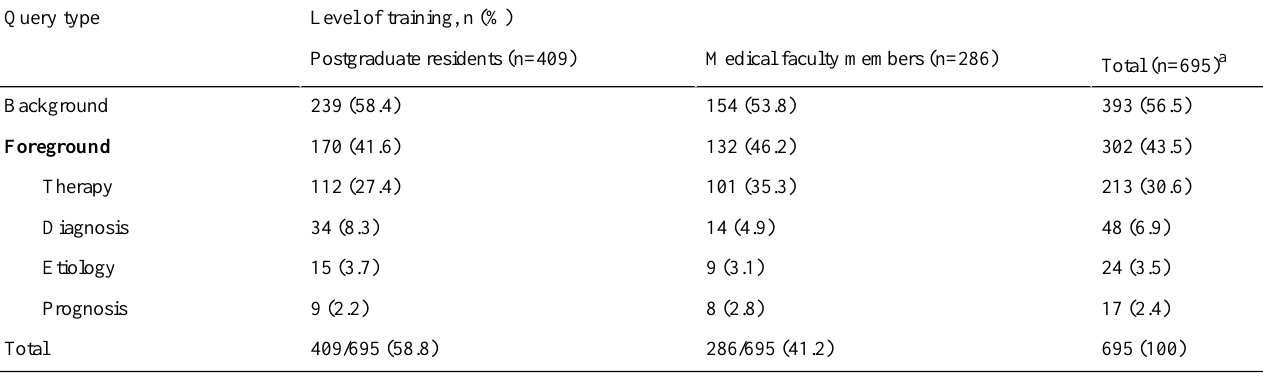
Table 1. Type of structured queries according to level of training.